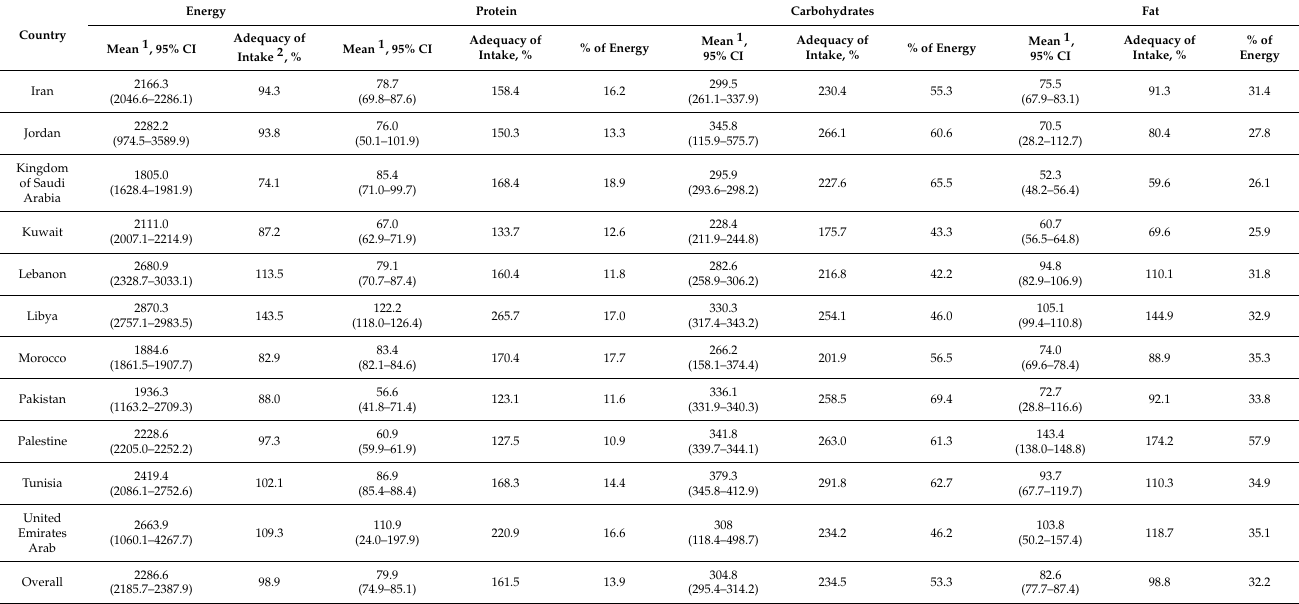
Table 3. Average daily intake (95% CI) and adequacy of energy and macro-nutrient of people in the countries sampled in the Eastern Mediterranean